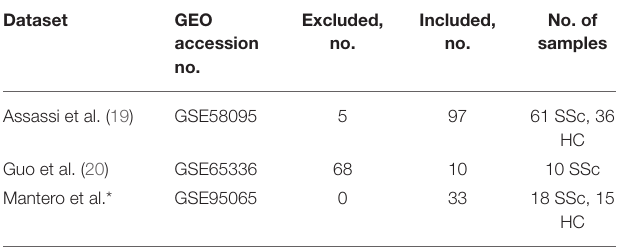
TABLE 1 | Studies included in the analysis a .